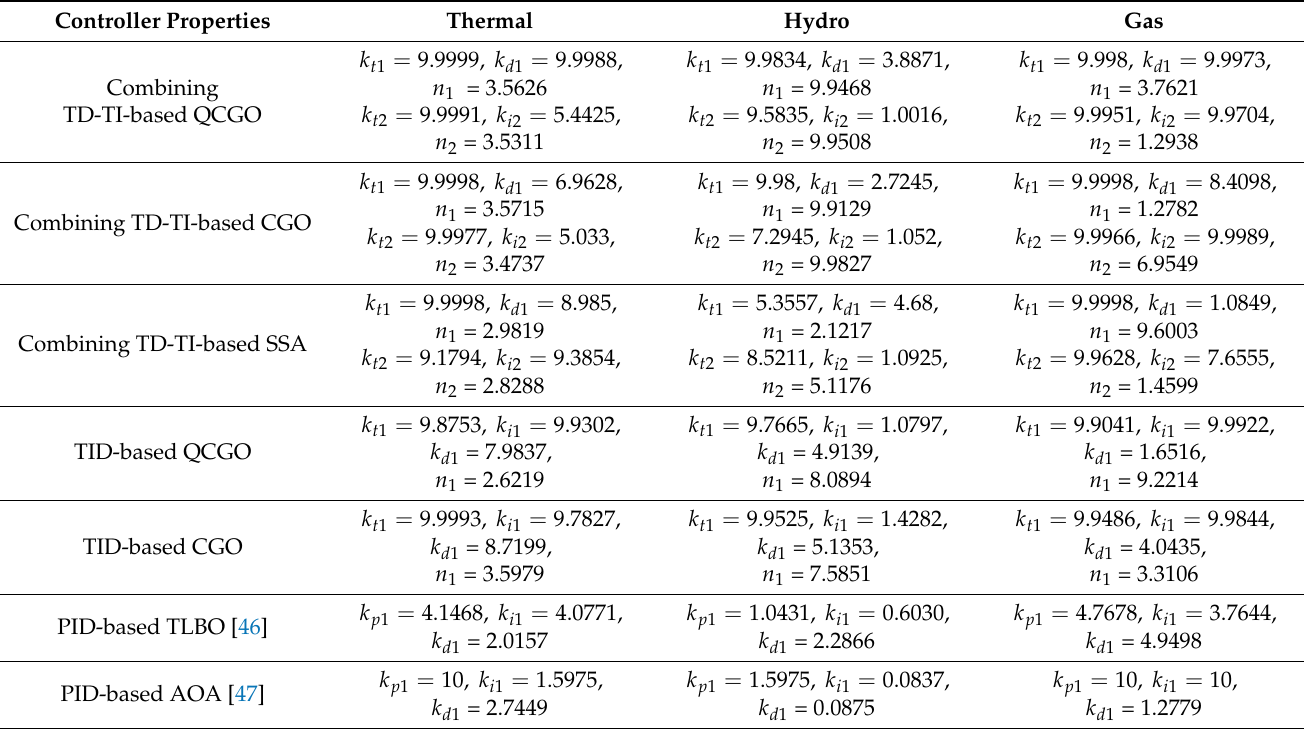
Table 7. The optimum parameters of the different controllers.